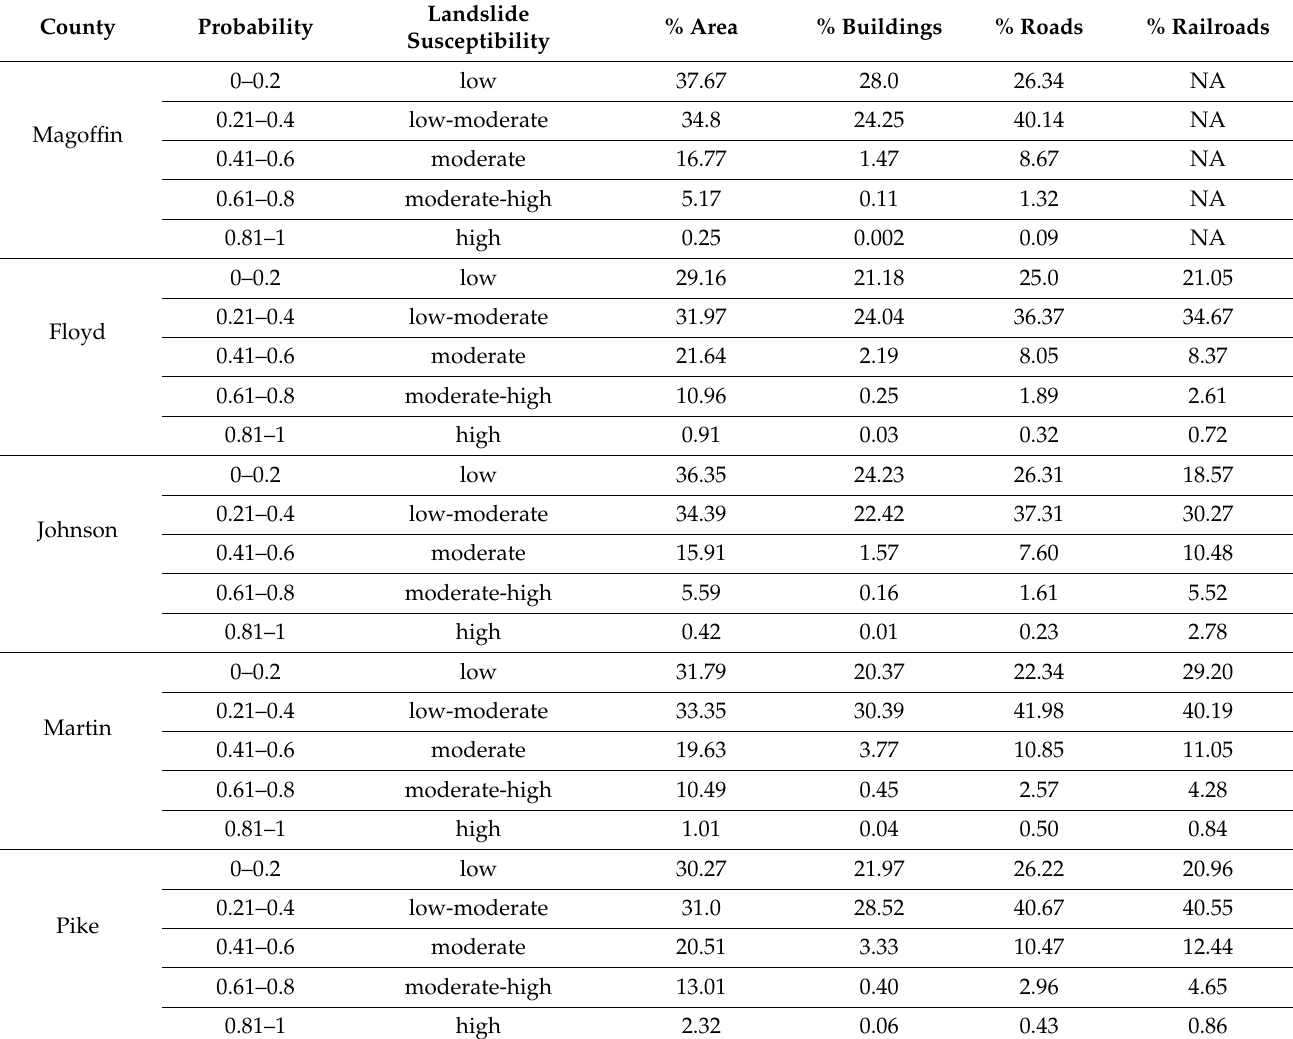
Table 2. Landslide susceptibility and intersection of assets for Magoffin, Floyd, Johnson, Martin, and Pike